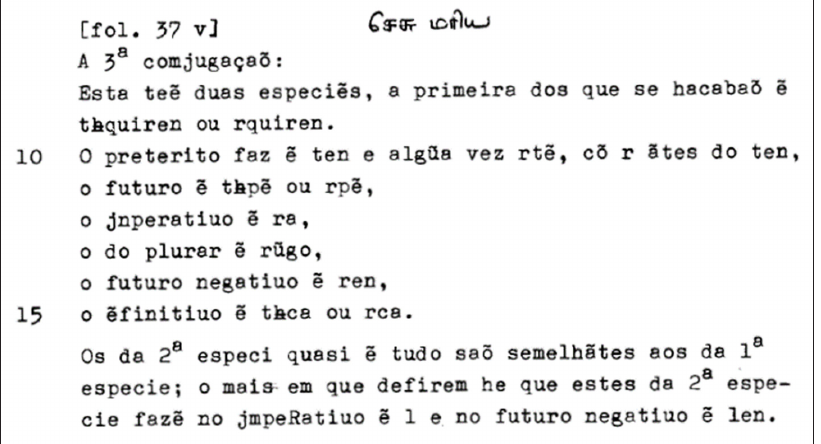
Figure 7: Vermeer 1982 transcription of folio 37 v in Codex 3141 (BNP, Lisbon): Preliminary presen- tation of the 3 rd